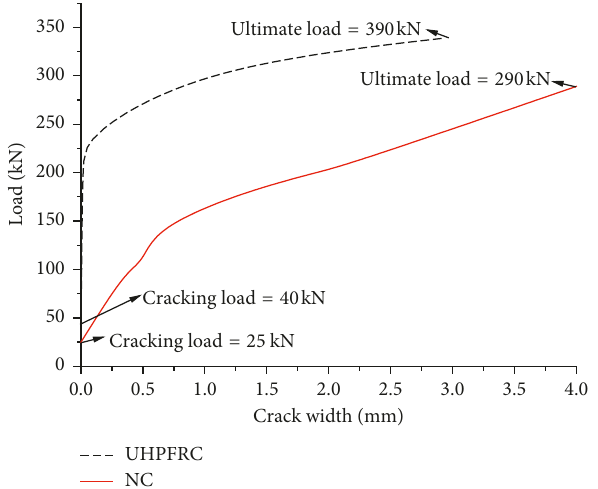
Figure 6: Load versus crack width curves of UHPFRC and NC arches.